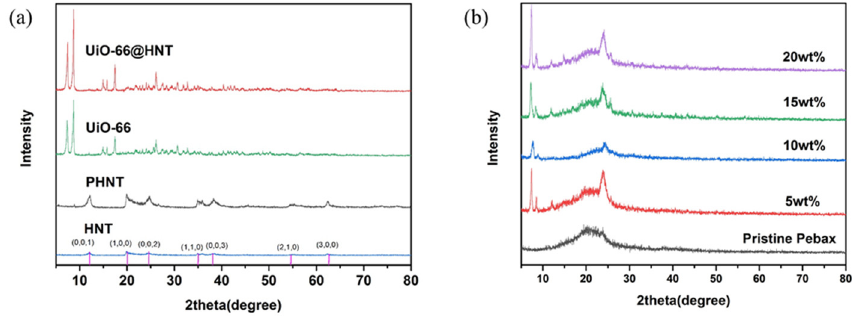
Figure 4. XRD patterns of: ( a ) HNT, PHNT, UiO-66, and UiO-66@HNT; ( b ) Pristine Pebax and MMMs with different loadings.